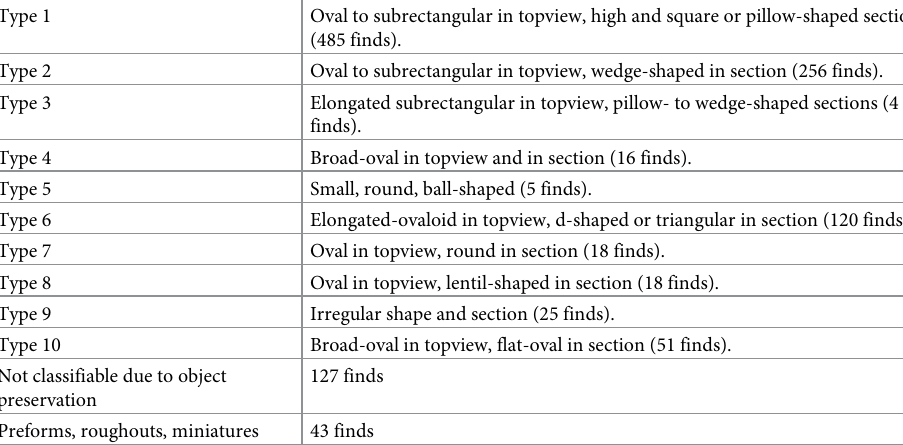
Table 1. Typology of the handstones from Go¨bekli